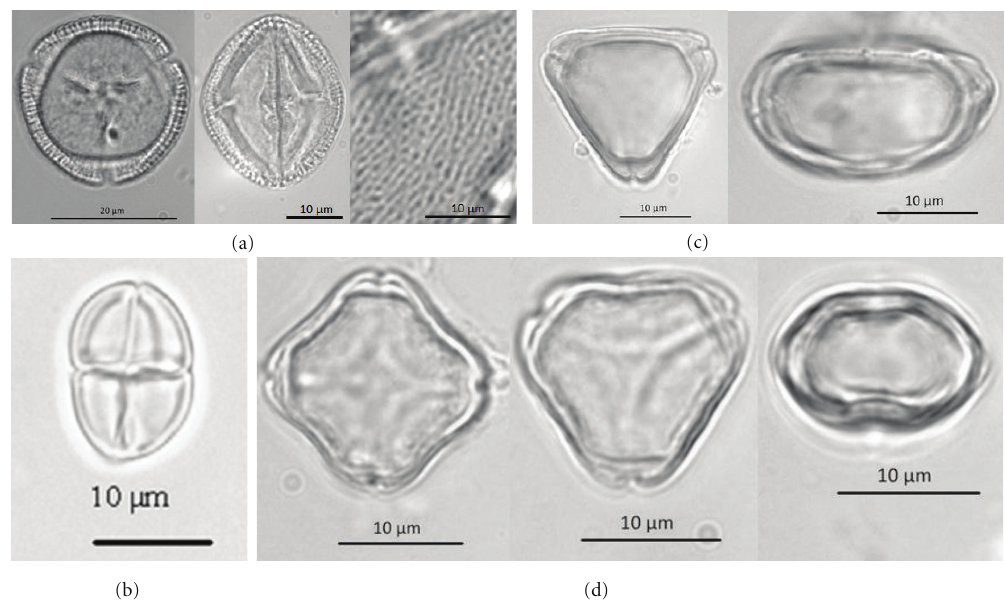
Figure 6: Photomicrographs of pollen grains of the most used species by Scaptotrigona a ff . depilis . (a) Schinus terebinthifolius Raddi (Anacardiaceae) in polar and equatorial view and detail of the exine. (b) Mimosa sp1 (Fabaceae), a polyad. (c) Eucalyptus citriodora Hook. (Myrtaceae) in polar and equatorial view. (d) Syzygium cumini (L.) Skeels (Myrtaceae) in polar and equatorial view and detail of the exine.